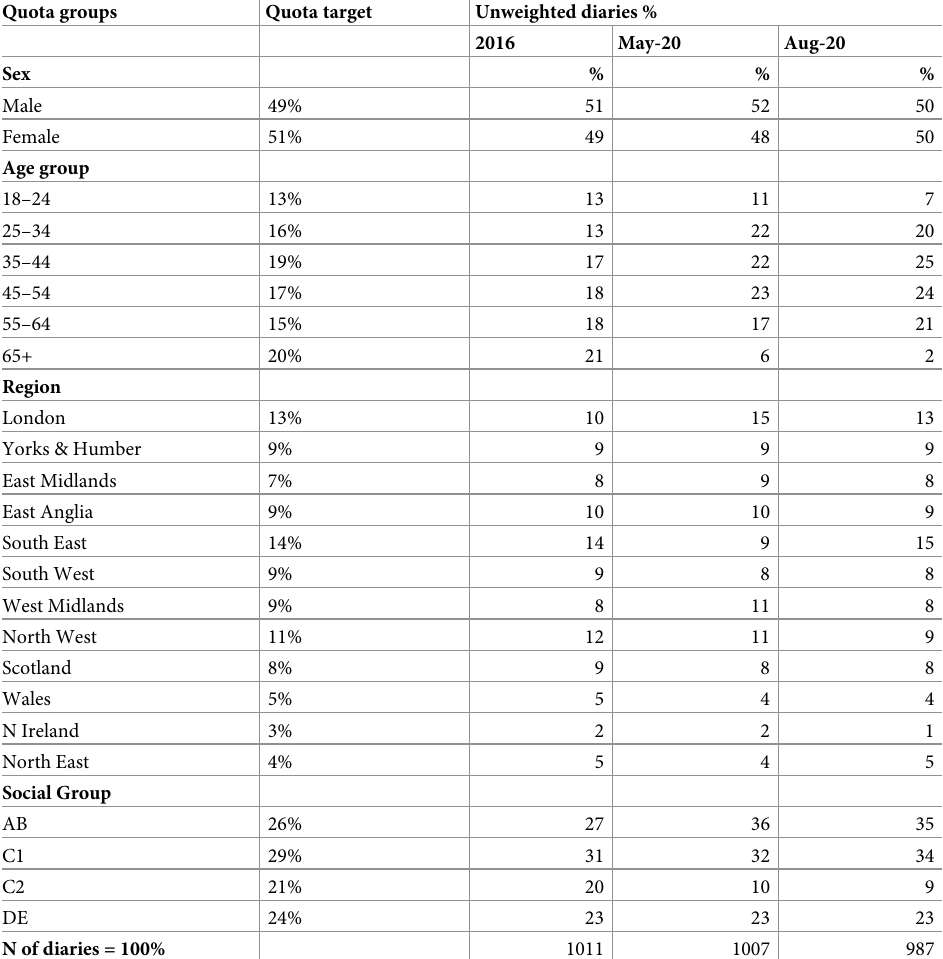
Table 1. Sample quota groups, target percentages and achieved % of diaries: CaDDI 3-wave